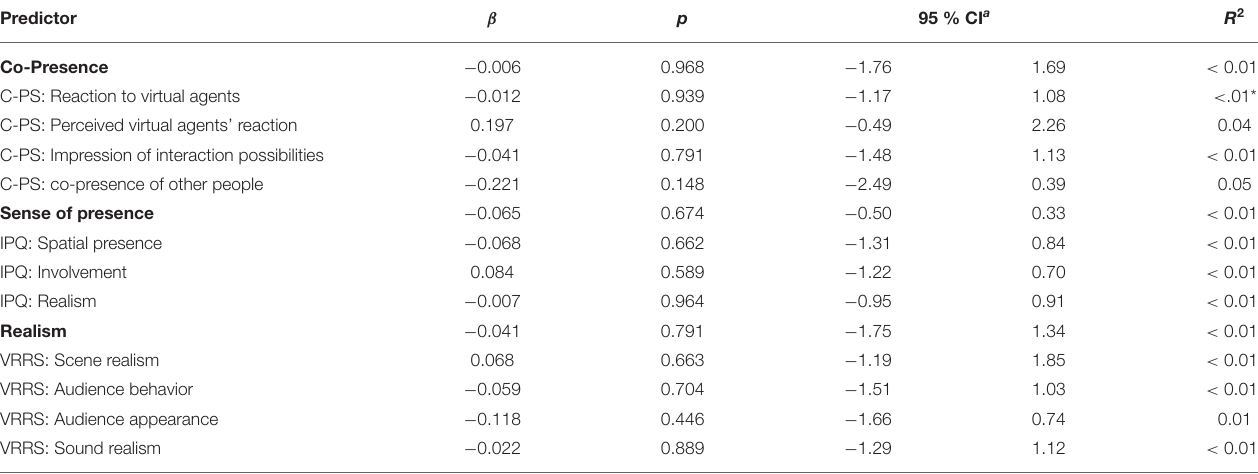
TABLE 1 | Simple linear regression results for considered moderators of performance (social facilitation). Predictor β p Co-Presence